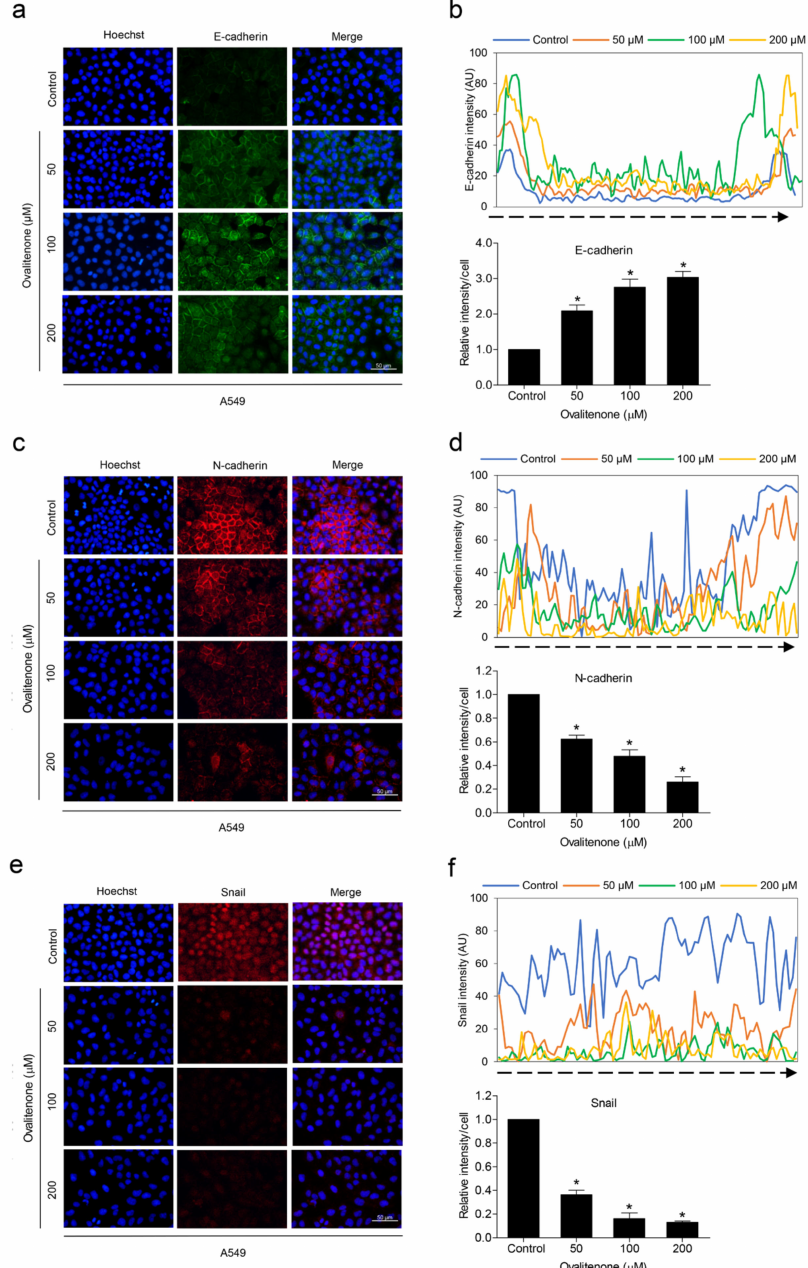
Figure 6. Ovalitenone suppresses EMT. ( a , c , e ) A549 cells were treated with ovalitenone at indicated concentrations for 24 h. The cellular levels of E-cadherin, N-cadherin, and Snail were determined by immunofluorescence analysis. ( b , d , f ) The fluorescence intensity was analyzed by ImageJ software. Values represent the mean ± SEM. ( n = 3). * p < 0.05 compared with untreated